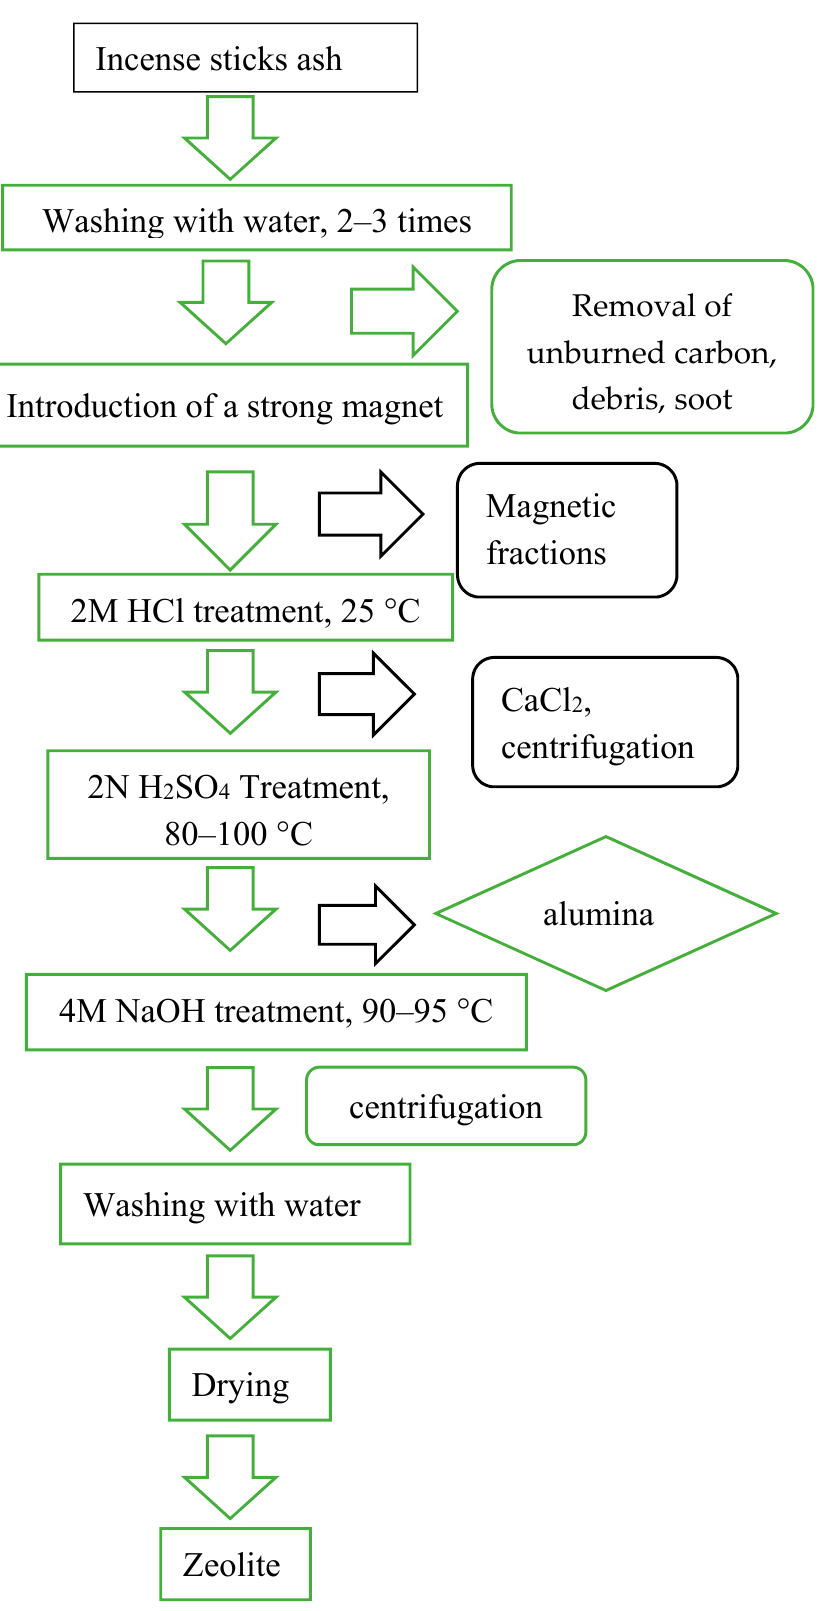
Figure 2. Schematic steps engaged in the formation of zeolites from incense sticks ash (ISA) [66]